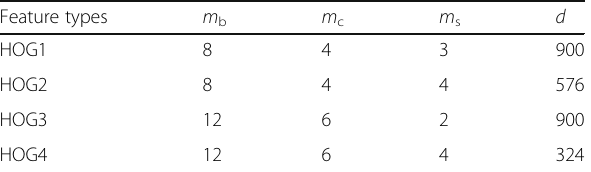
Table 3 Recognition rates of different